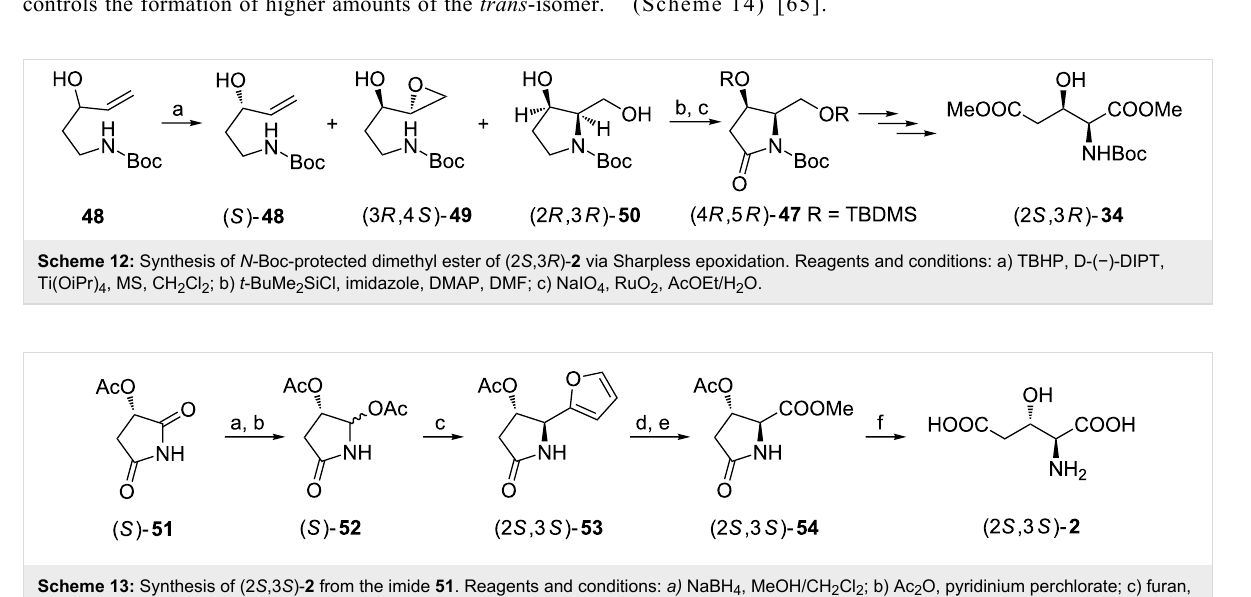
Scheme 13: Synthesis of (2 S ,3 S )- 2 from the imide 51 . Reagents and conditions: a) NaBH 4 , MeOH/CH 2 Cl 2 ; b) Ac 2 O, pyridinium perchlorate; c) furan, ZnCl